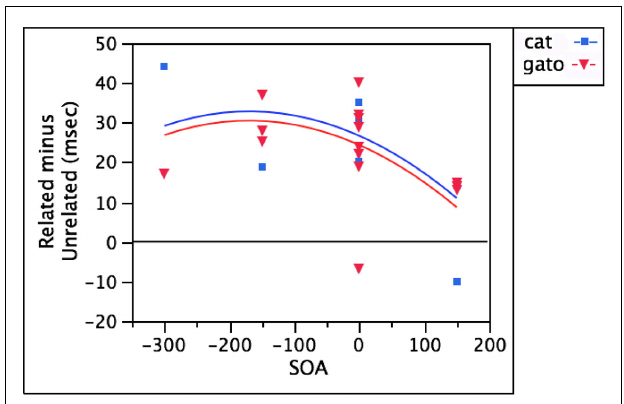
FIGURE 3 | Equivalent semantic interference from target language and non-target language distractors.